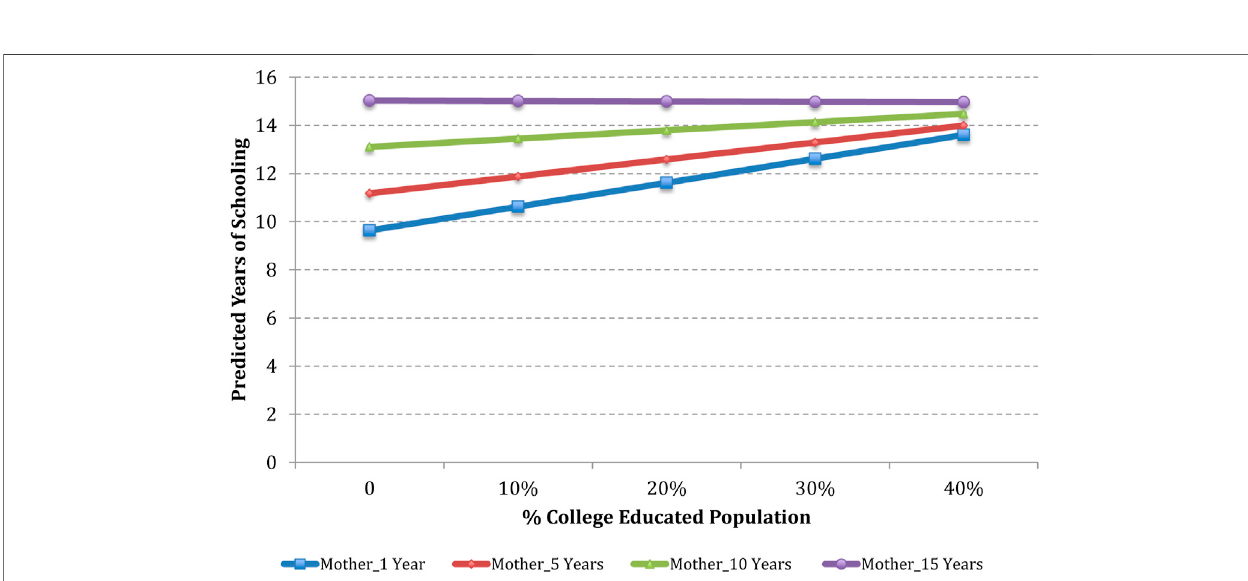
Frontiers in Sociology |